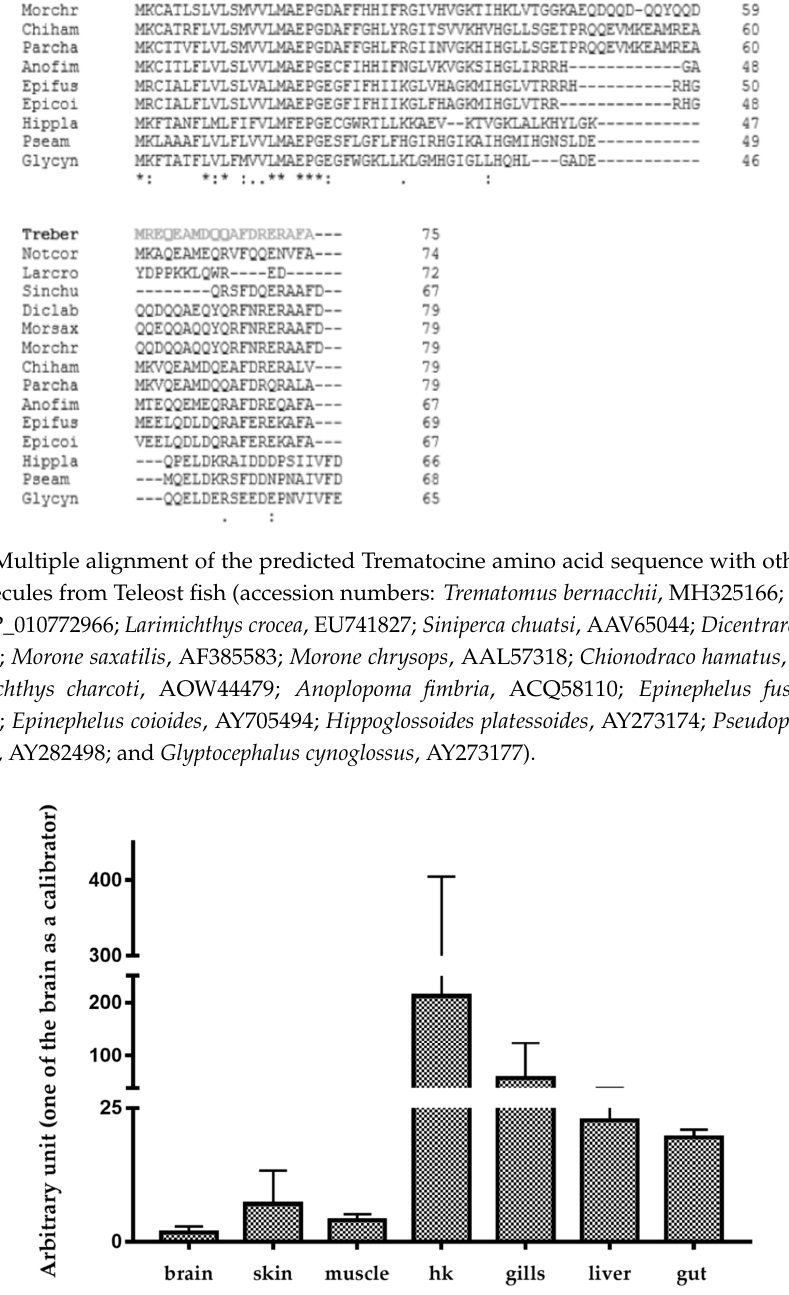
Figure 3. Trematocine expression analysis after in vivo immunization with Psychrobacter sp. TAD1 in head kidney and spleen after 8 h and 72 h. The results are expressed as mean + SD and the asterisk indicate the significance level with respect to control (0 h). * = p < 0.05 . 2.3. Trematocine Mature Peptide Structure Evaluation of the Trematocine secondary structure was carried out by circular dichroism spectroscopy, as described in Section 4.3. In buffer solution, the peptide was unstructured, as shown by the minimum found around 200 nm. Upon addition of increasing amounts of large unilamellar vesicles (LUVs), it gradually switched to a α -helix configuration, as revealed by the two minima at 208 nm and 222 nm (Figure 4). This happened in the presence of both anionic (PE) and zwitterionic lipid LUVs, with a significant switch at the 1:9 P/L ratio. Interestingly, there was a faint 230 nm minimum at the 1:2 P/L ratio, peculiar of interactions among aromatic residues [28], putatively the N-terminal Trp and Phe, thus suggesting a cooperative effect among peptide monomers. The results